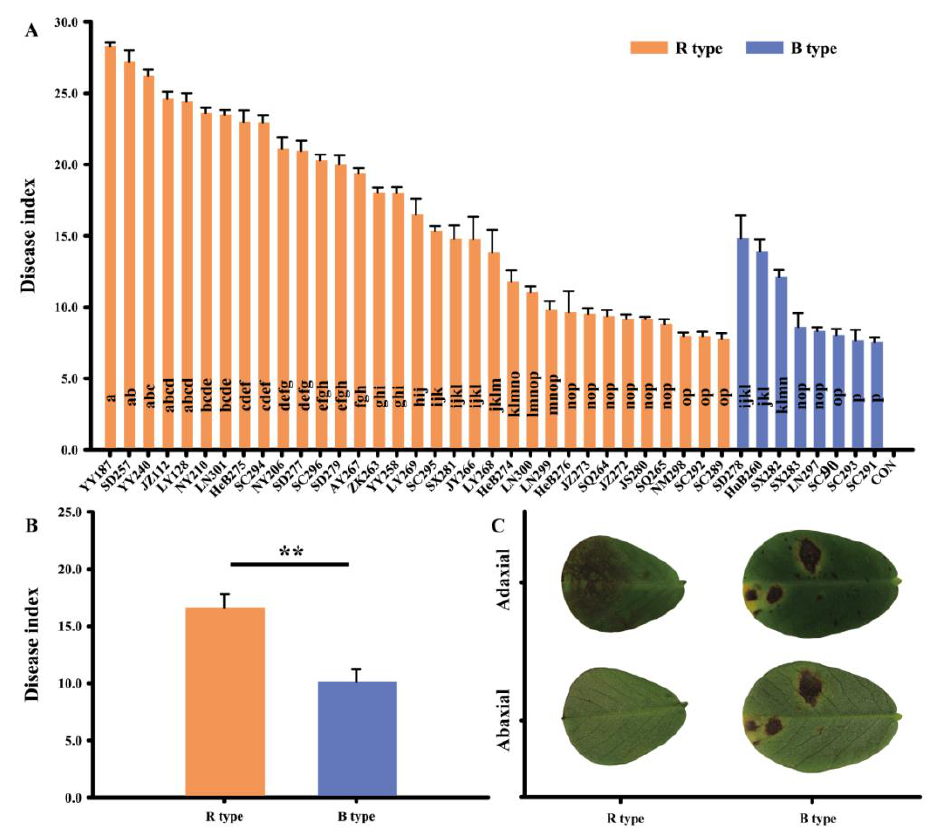
Figure 1. Pathogenicity assays and lesion phenotype of 41 D. arachidicola isolates. ( A ) The disease index of peanut seedlings infected by 41 D. arachidicola isolates at 14 dpi; CON denotes non-infected peanut seedlings. Letters on the bars denote significant differences in disease index at 0.05 level; error bars denote the standard error of the mean. ( B ) The average disease index of peanut seedlings infected by isolates of different lesion phenotypes at 14 dpi. “**” denotes significant differences at 0.05 level; error bars denote the standard error of the mean. ( C ) Adaxial and abaxial leaf surfaces of different lesion phenotypes showed at the top and bottom, respectively.